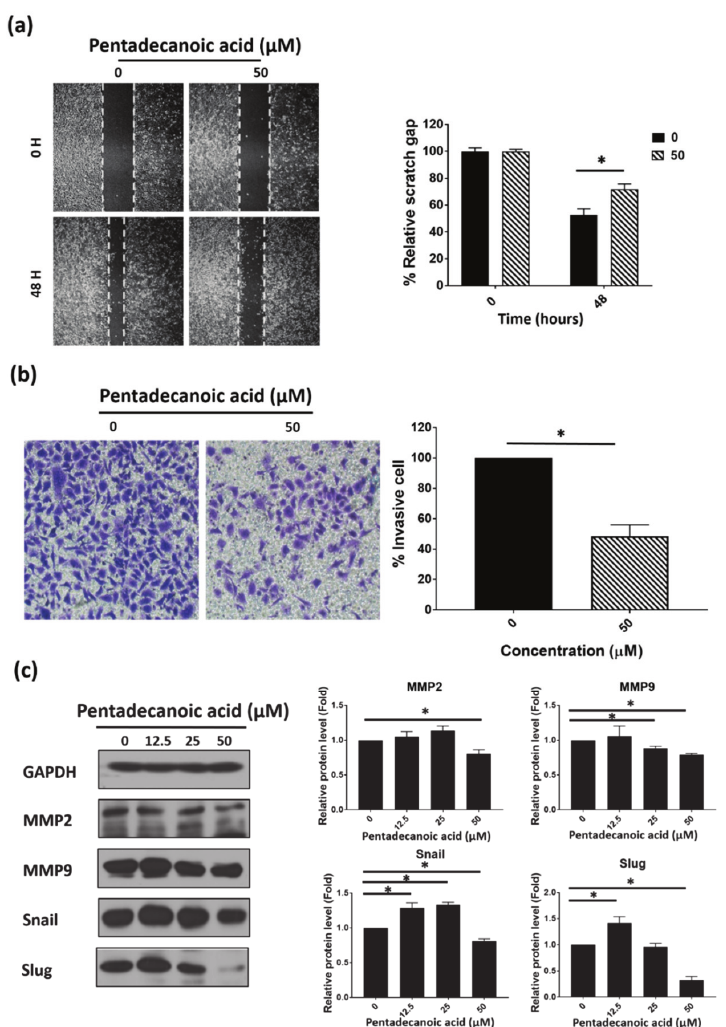
Figure 3. Pentadecanoic acid inhibits the migration and invasion of MCF-7 / SC. ( a ) Cell migration was determined by the wound healing assay following 48 h of exposure. ( b ) Invasive cells were stained with crystal violet after treatment with pentadecanoic acid for 48 h (magnification 100 × ). ( c ) Western blot analysis of epithelial–mesenchymal transition (EMT) markers in MCF-7 / SC was performed after pentadecanoic acid treatment for 48 h. GAPDH was used as a loading control. Data are shown as the mean ± standard deviation of three biologically independent experiments. * p < 0.05 vs.